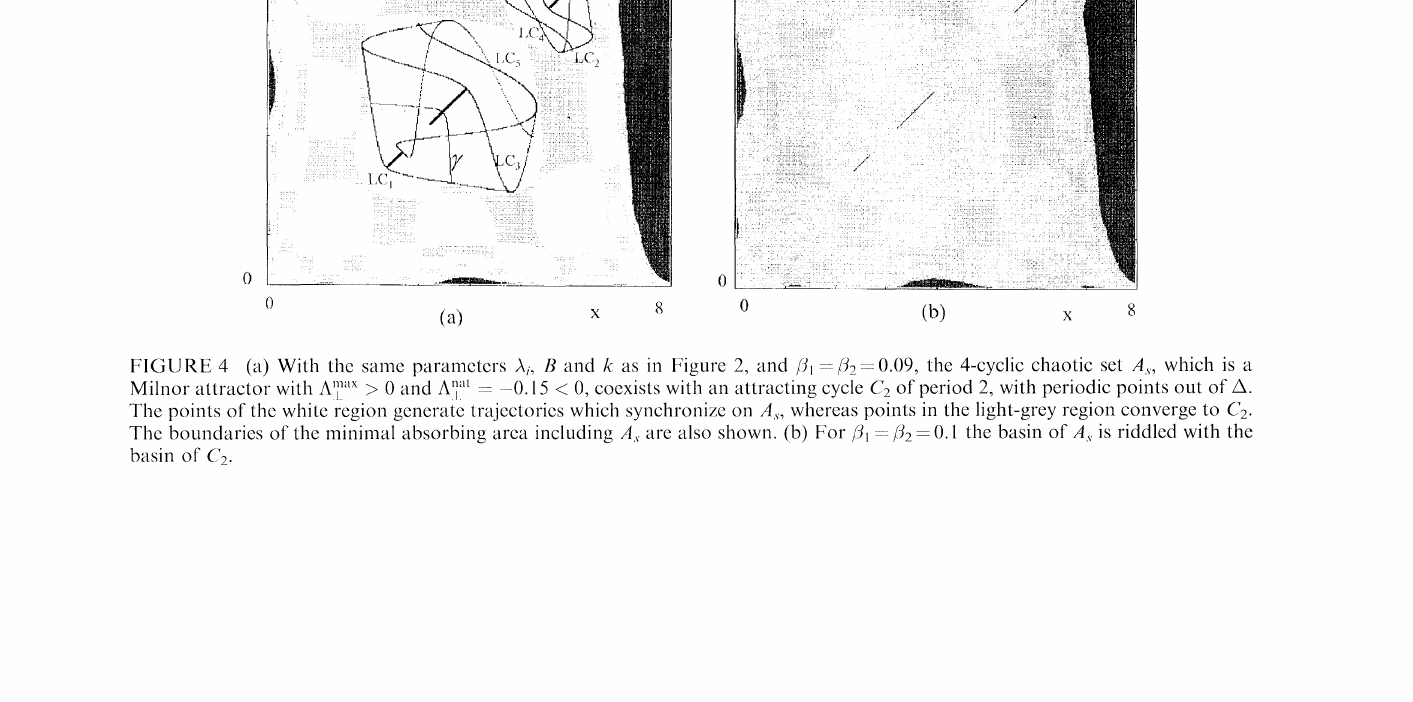
FIGURE 3 With the same parameters k,., B and k as in Figue and 31--J2--0.19, A TM > 0, hence a generic trajectory starting from the white region tills the whole absorbing area, bounded by segments of critical arcs.